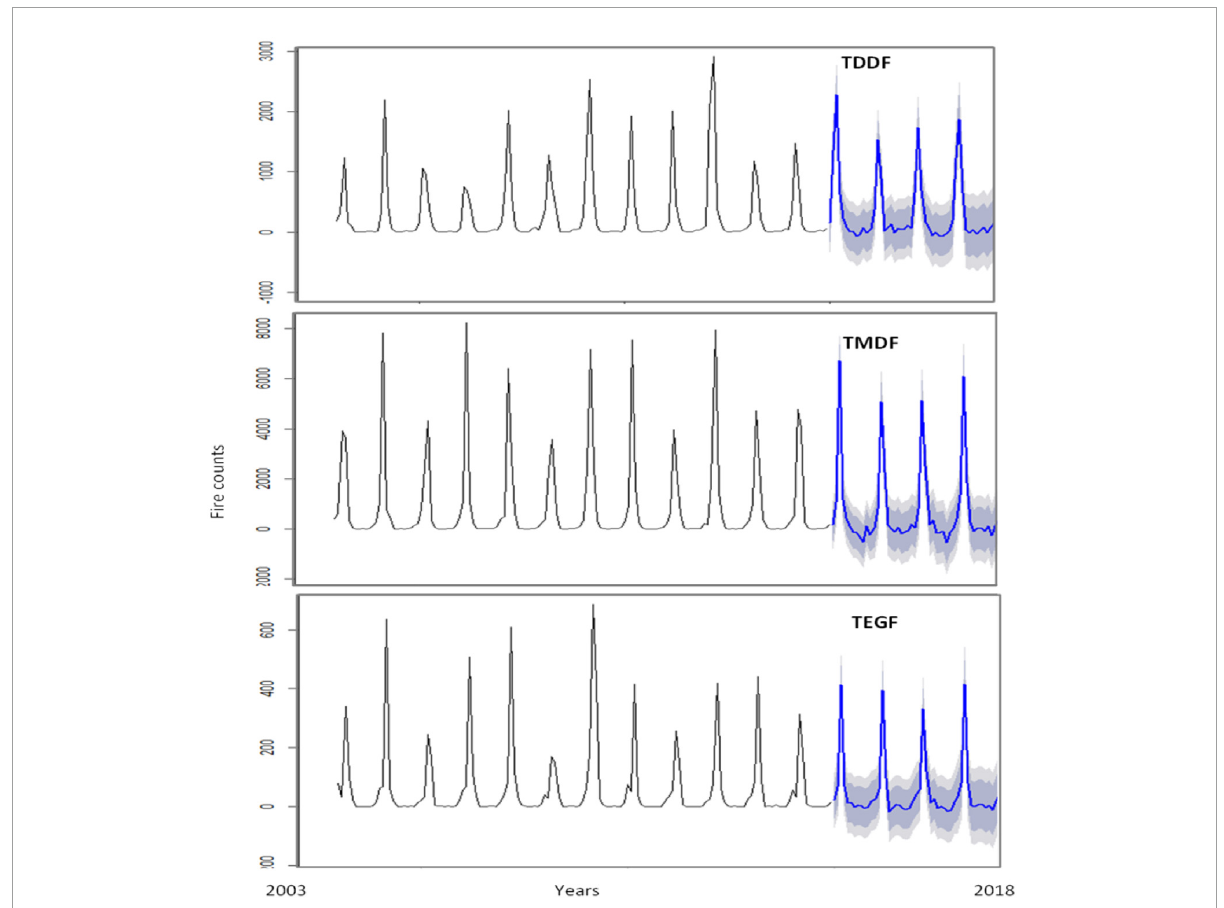
FIGURE9 Forest fire forecasting based on ARIMA with regressors (temperature and dry days) model for Tropical Dry Deciduous Forests (TDDF), Tropical Moist Deciduous Forests (TMDF) and Tropical Evergreen Forests (TEGF). Blue lines depict forecasted fires and shaded area depicts prediction interval (inner to outer 80 and 95%,